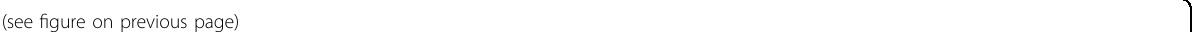
Fig. 5 TROAP-mediated the cytoplasmic localization of DYRK1A and DYRK1B activates Akt/GSK-3 β signaling. A IF double-staining with antibodies against TROAP (red) and DYRK1A or DYRK1B (green) in PLC8024 cells with or without TROAP silence. Cell nuclei were stained with DAPI (blue). Scale bar, 10 μ m. Representative fl uorescence signals in cytoplasm and nucleus indicated by white line were analyzed with ImageJ software and summarized in right panel. In right panel, data were indicated as mean ± SD; two-sided Student ’ s t -test; *** P < 0.001; ns, no statistical signi fi cance. B IHC staining with antibodies against DYRK1A and DYRK1B in xenograft tumors derived from vector or TROAP-transfected Huh7 cells. Scale bar, 50 μ m. C The protein expressions of TROAP, DYRK1A, and DYRK1B in cytoplasm and nucleus in Huh7 cells transfected with vector or TROAP and PLC8024 cells with or without TROAP silence were analyzed with western blotting, respectively. GAPDH and Histone H3 were also severally tested as cytoplasmic and nuclear protein indicators. C, cytoplasm; N, nucleus. D The activation of Akt/GSK-3 β signaling in HepG2 and Huh7 cells after transfection of vector (Vec) or TROAP (TRO) was analyzed by western blotting. E Western blot was used to analyze the activation of Akt/GSK-3 β signaling in vector or TROAP-transfected Huh7 cells under treatments with DMSO or AZ191 (1 μ M, 12hours). In panels D and F , β -Tubulin was also tested as a loading control. Relative expressions of phosphorylated Akt and GSK-3 β were analyzed with ImageJ software and summarized in right